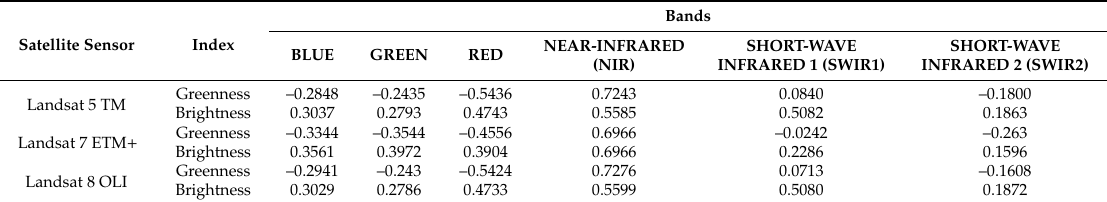
Table 1. Coe ffi cients for tasseled cap greenness and brightness.